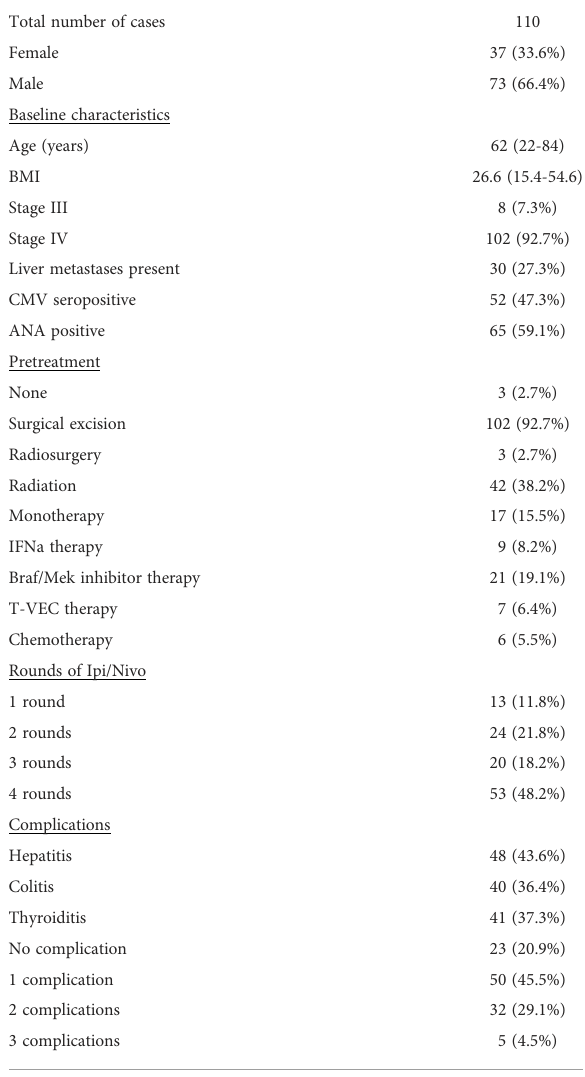
TABLE 1 Characteristics of study